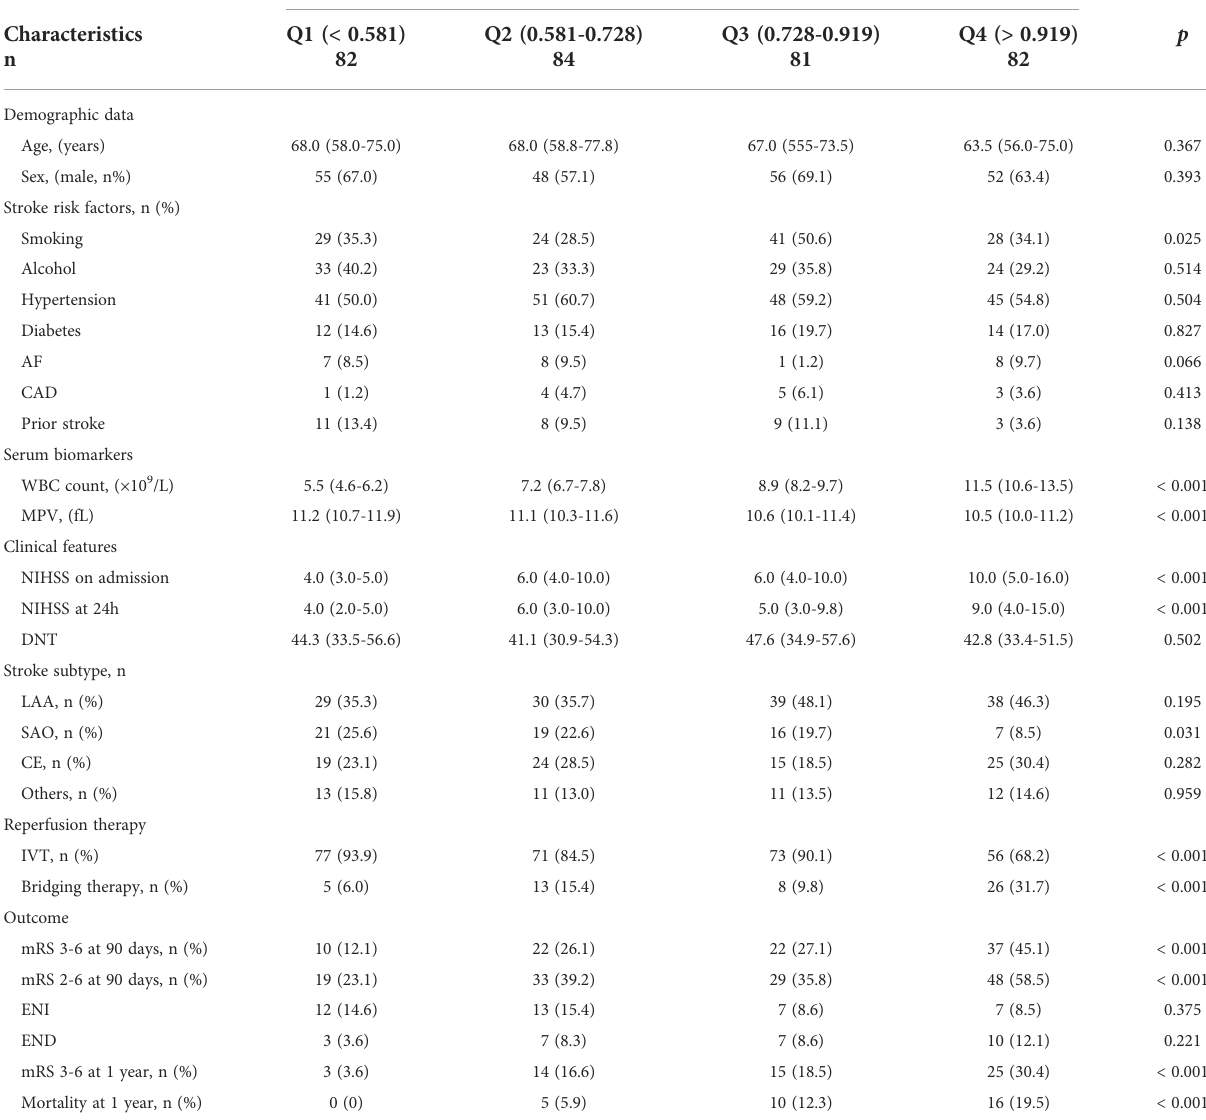
TABLE 2 Comparisons of baseline characteristics and outcomes between groups divided according to WMR